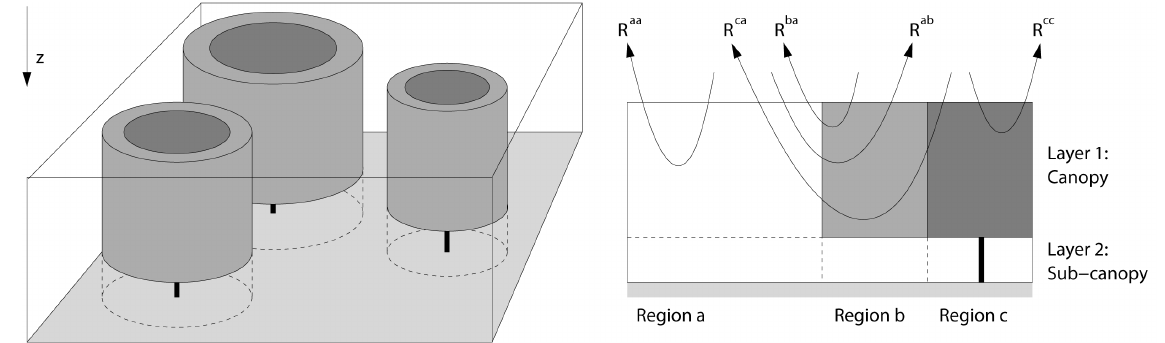
Figure 1. Schematic of the idealized vegetation considered in this paper, illustrating the meanings of Layers 1 and 2 and Regions a , b and c . The diagram on the right also illustrates the interpretation of the elements of the reflectance matrix R given in Eq.